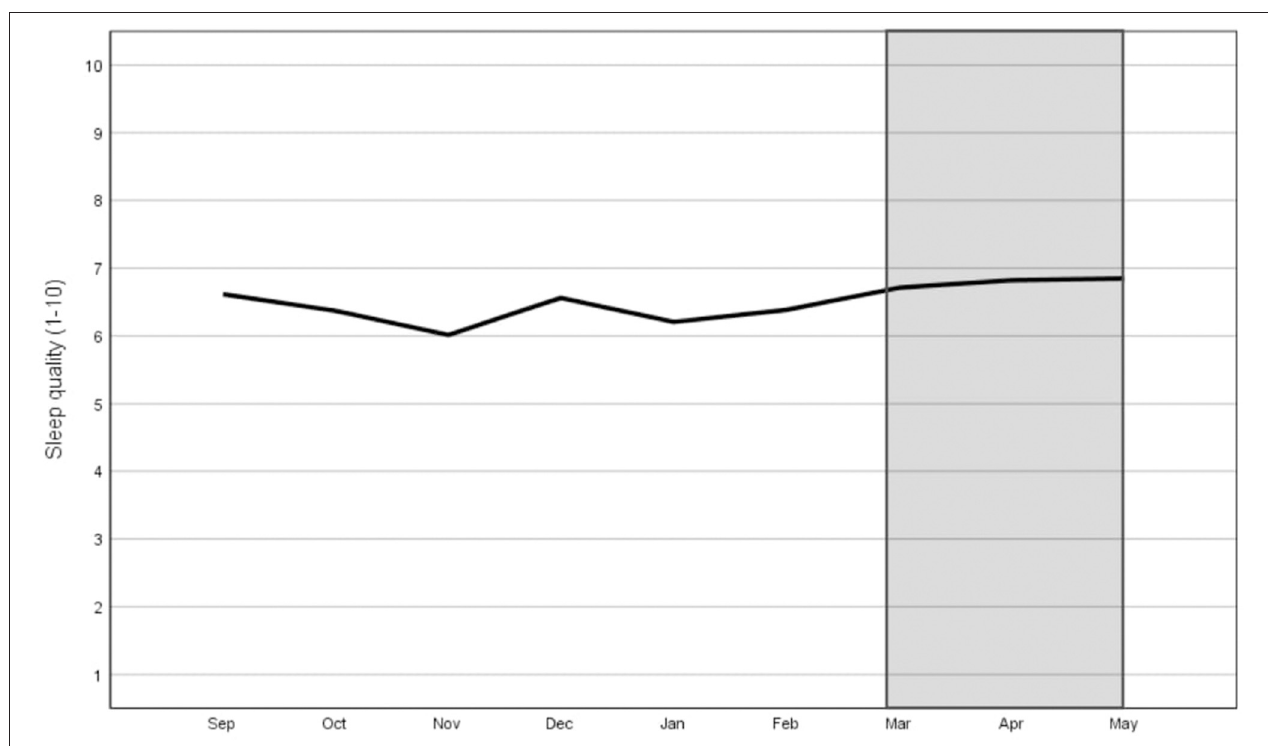
FIGURE 2 | Monthly sleep quality score (ranging from 1 to 10) during the pre-COVID-19 period (Sep-Feb) and during the COVID-19 lockdown (Mar-May: grey